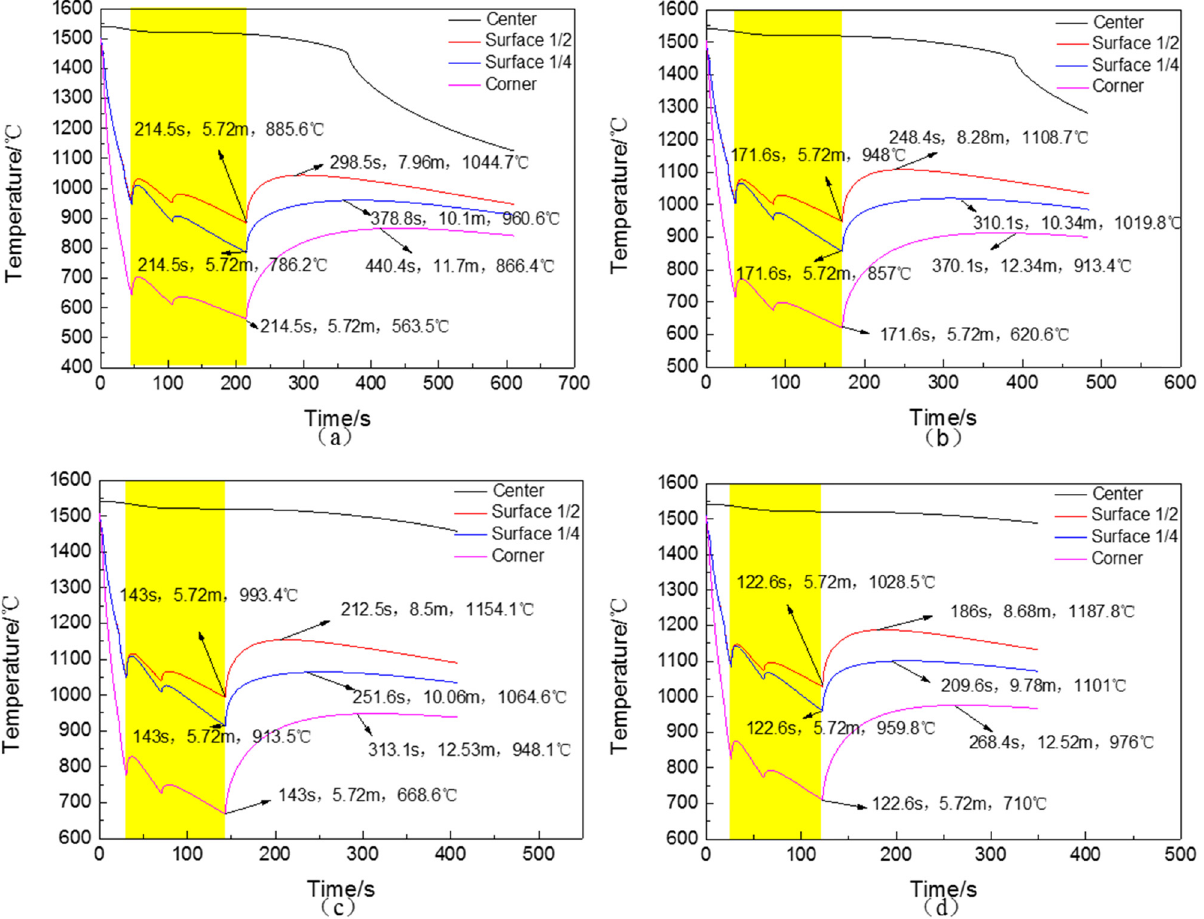
Figure 2: Variation of billet temperature under di ff erent casting speeds: ( a ) 1.6 m · min − 1 , ( b ) 2 m · min − 1 , ( c ) 2.4 m · min − 1 , and ( d ) 2.8 m · min − 1